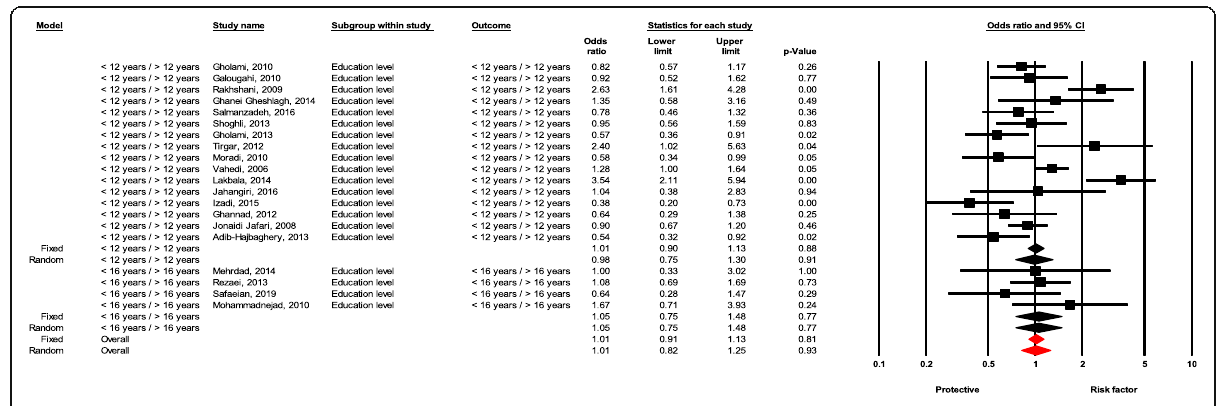
Fig. 4 Forest plot for relationship between education level and risk of NSI in Iran